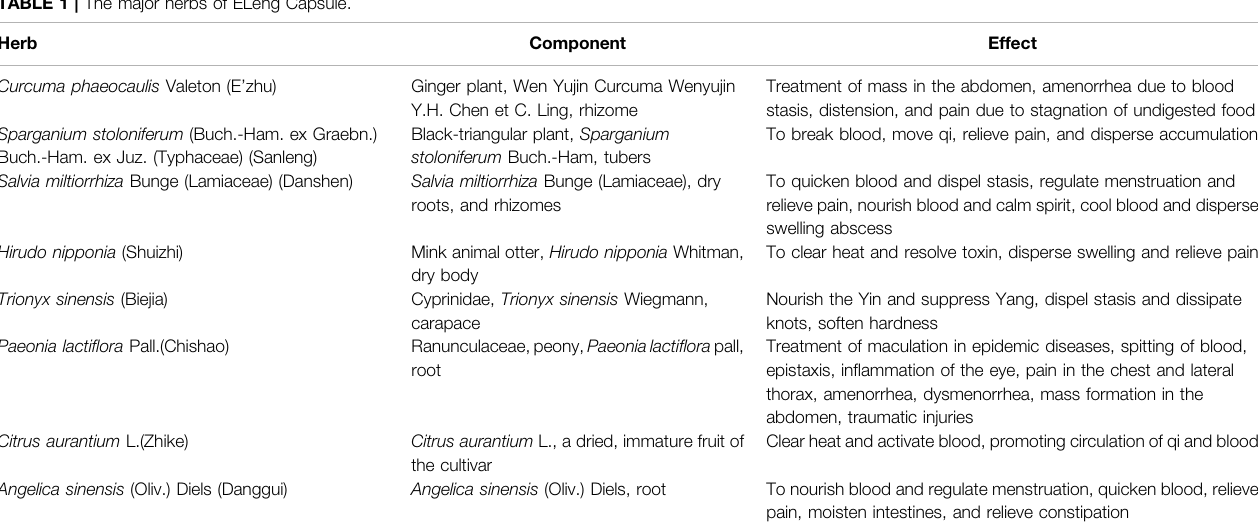
TABLE 1 | The major herbs of ELeng